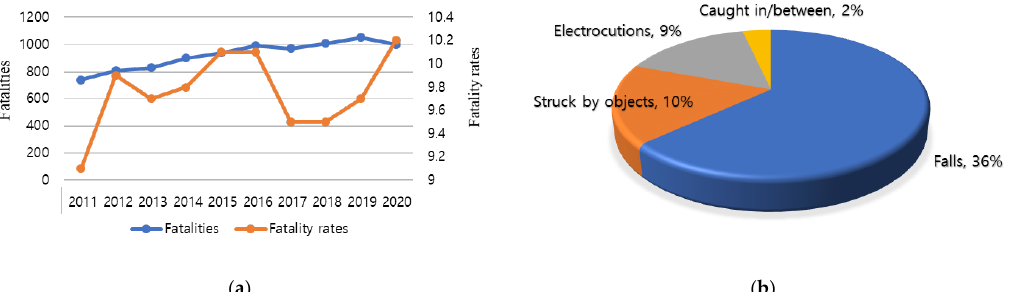
Figure 1. Construction accident trends reported by the Occupational Safety and Health Administration (OSHA) in 2021. ( a ) Construction fatalities and fatality rates *; * Fatality rates: Fatalities per 100,000 Full-Time-Equivalent works for the private-sector construction industry. ( b ) Four main causes of workplace deaths. According to the 2016 European Small Business Annual Report and 2015 US Small